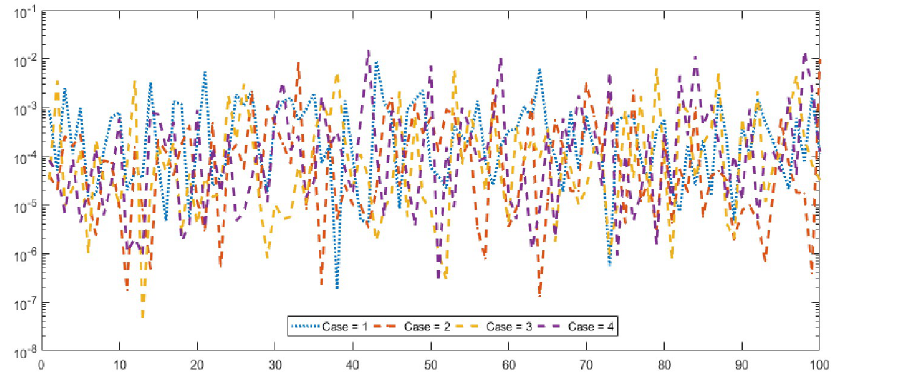
Fig 12. ENSE values for each case of problem 1.